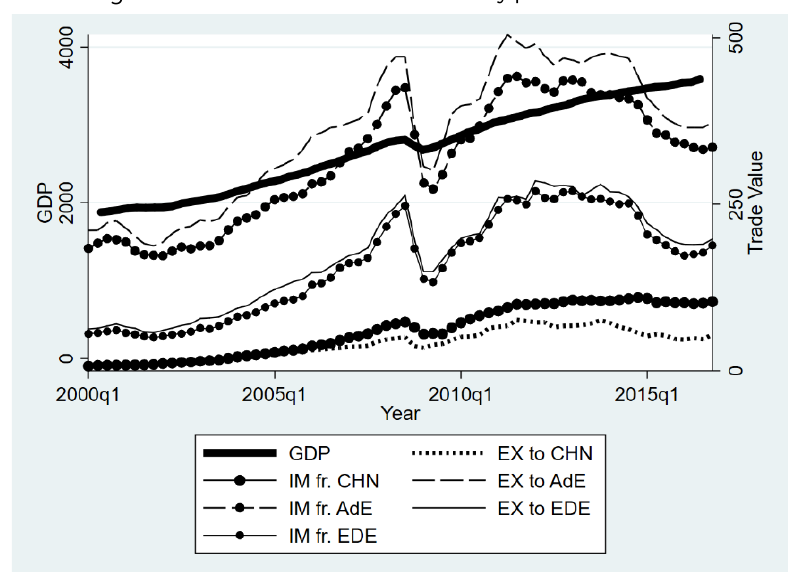
Figure 1 : Total GDP and trade volume by partners in 22